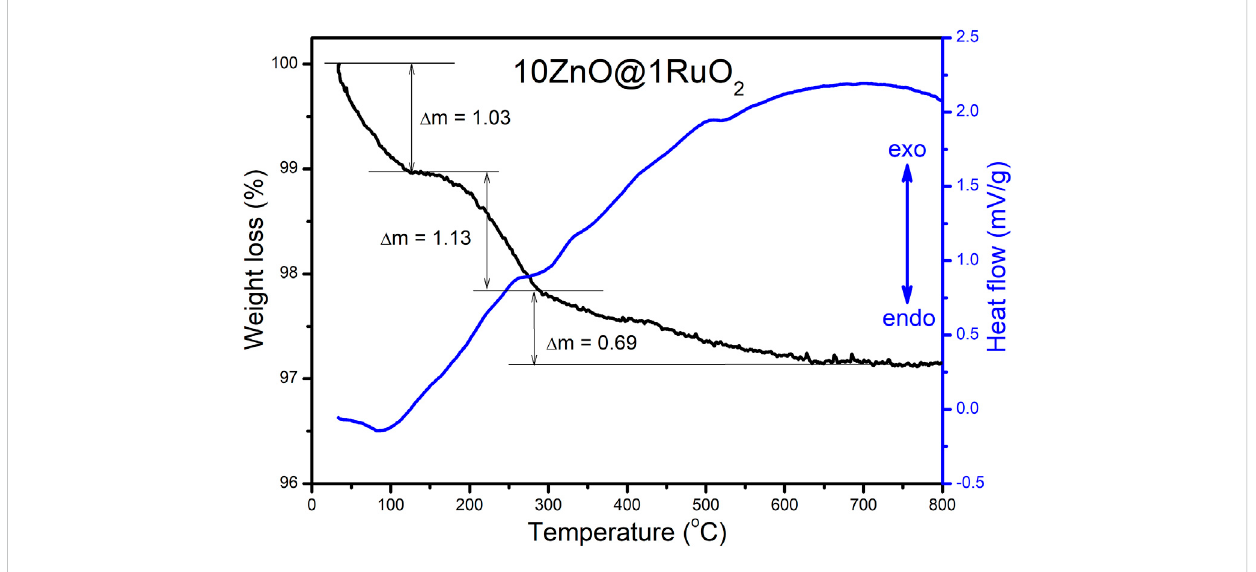
FIGURE 2 TG-DTA plots of 10ZnO@1RuO 2 particles.